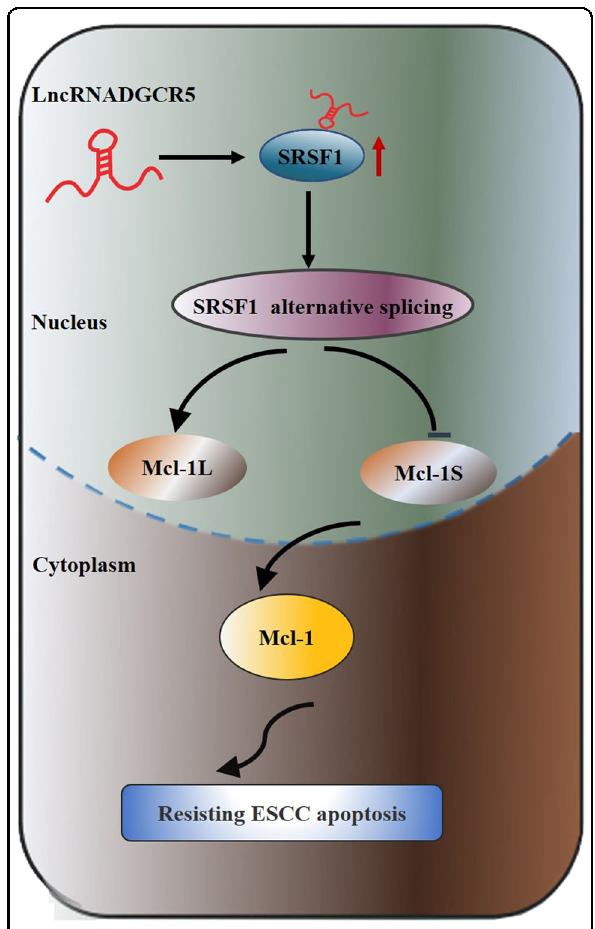
which DGCR5 involves in tumorigenesisof ESCC via SRSF1-mediated alternative splicing of